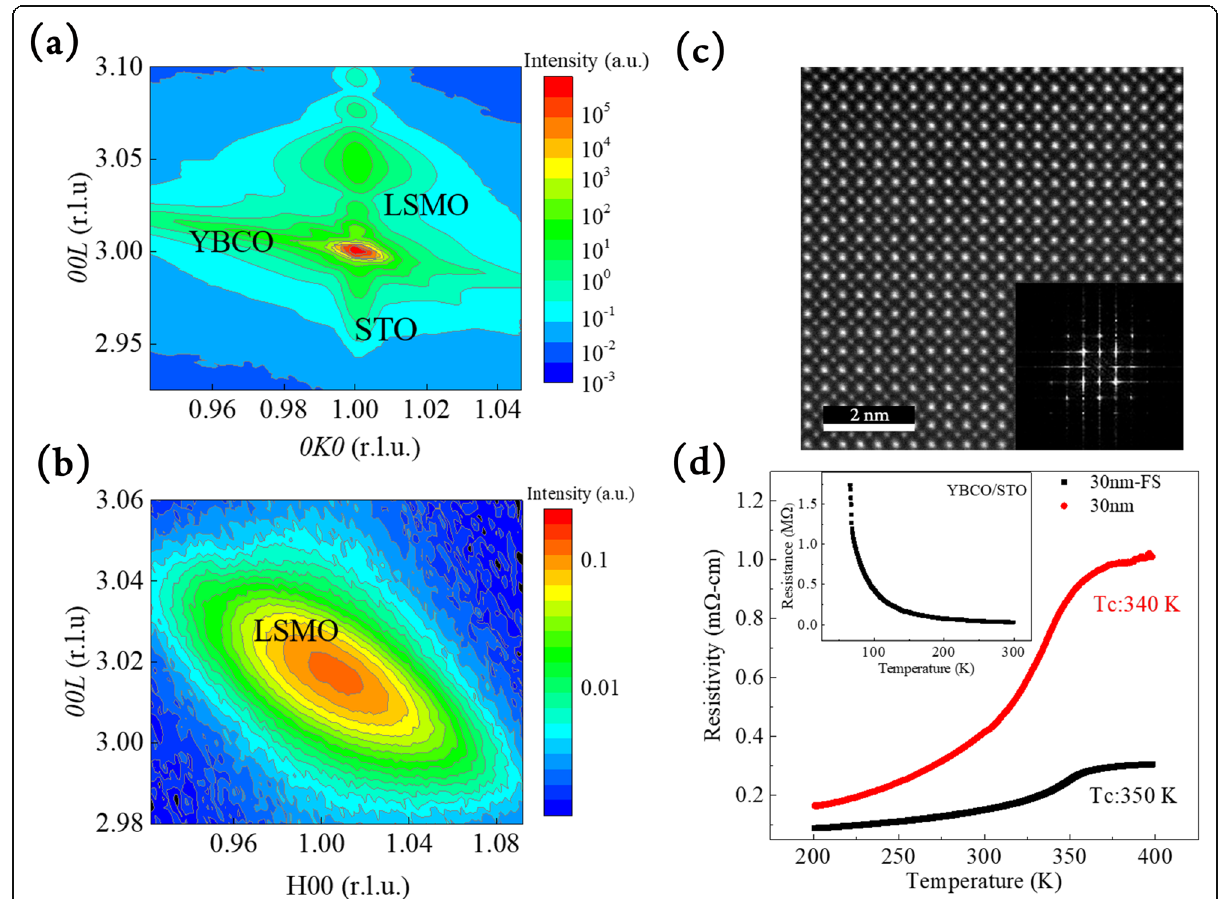
Fig. 3 a Reciprocal space mapping (RSM) around as-grown LSMO (103) and b RSM around freestanding LSMO (103). c Plan view high-angle annular dark-field (HAADF) image of freestanding LSMO. The inset is the FFT pattern. d Temperature dependence of resistivity of LSMO before and after freestanding. The inset represents the transport behavior of as-grown single insulating YBCO sacrificial